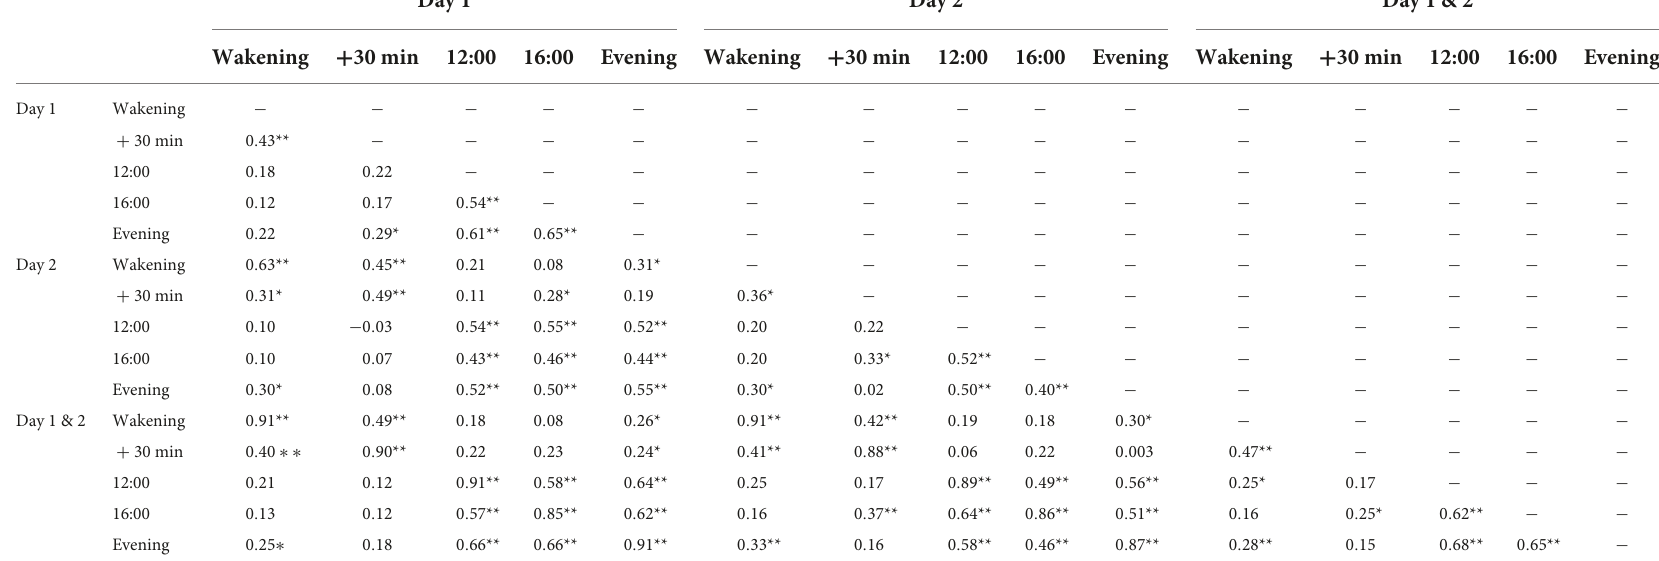
TABLE 3 Pearson’s correlations between all prenatal maternal cortisol